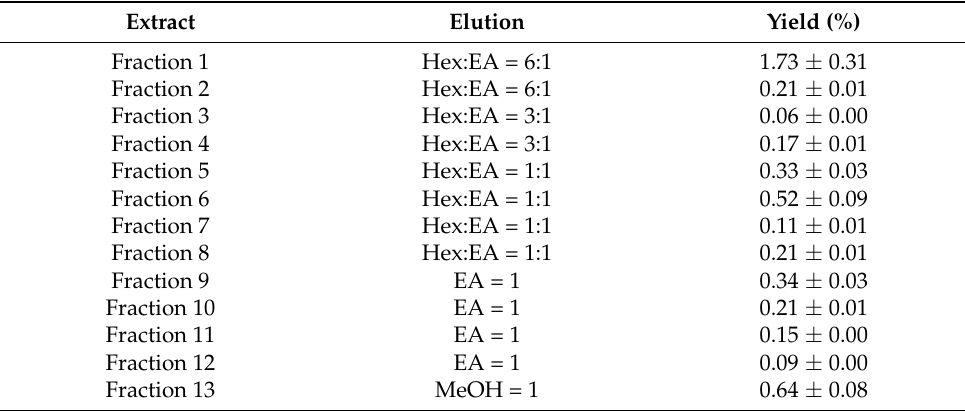
Table 3. The yield of various fraction of column